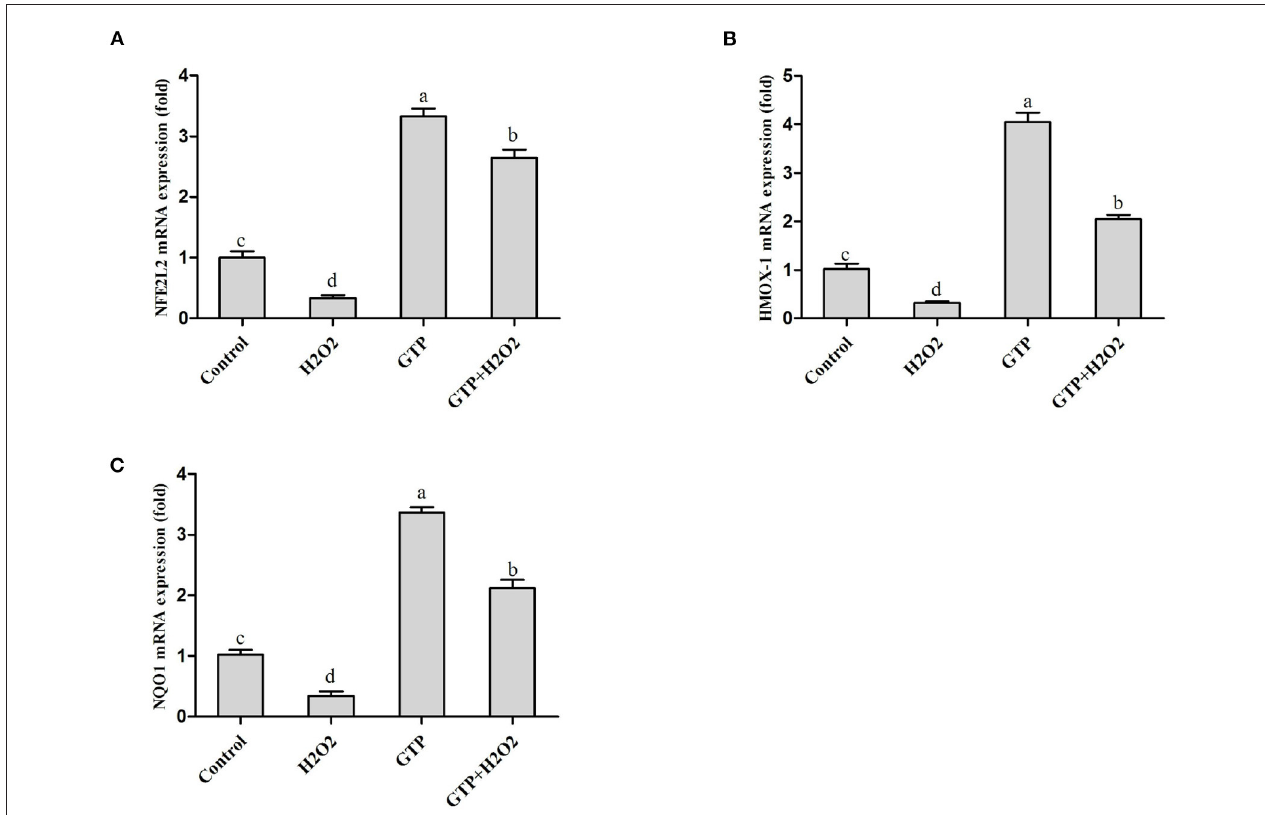
FIGURE 4 | GTP activated the NFE2L2 pathway. BMECs were treated with H 2 O 2 (500 µ M) and/or GTP (100 µ g/ml) for 12h. (A) The mRNA expression level of NFE2L2 in BMECs, (B) the mRNA expression level of HMOX1 in BMECs, and (C) the mRNA expression level of NQO1 in BMECs. a,b,c,d, the adjacent lowercase letters indicate significant difference, the alternate lowercase letters indicate extremely significant difference, and the same lowercase letters indicate insignificant difference.